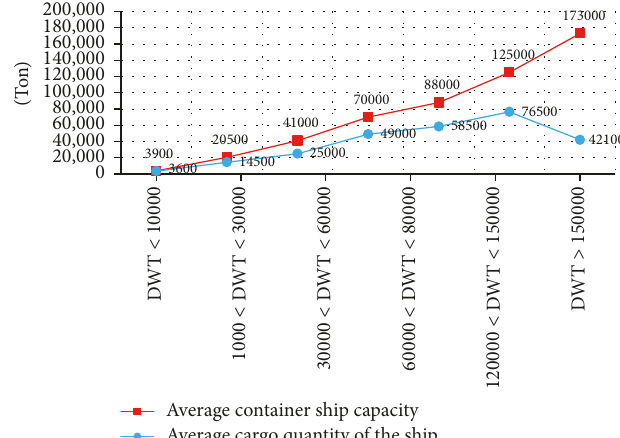
Figure 7: Average cargo quantity and capacity of the container ships of each group during the five peak years (2008, 2009, 2010, 2011, and 2012) in the Shahid Rajaee